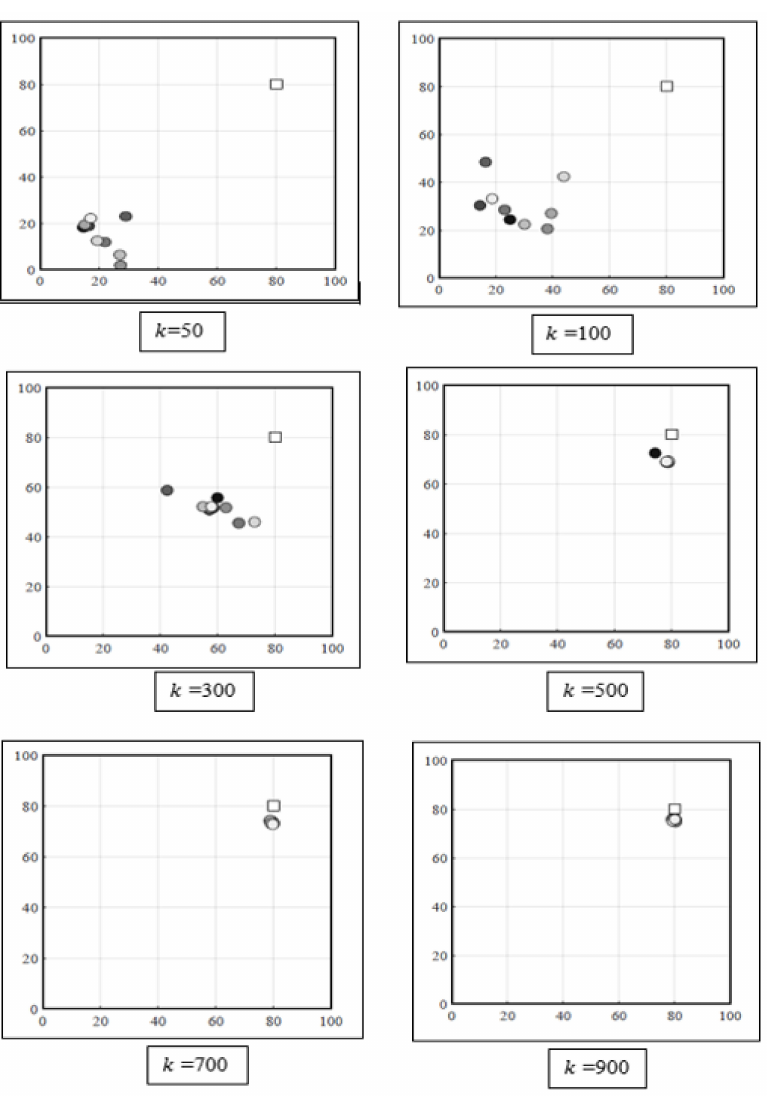
Figure 8. Agent movement to meet at rendezvous point.